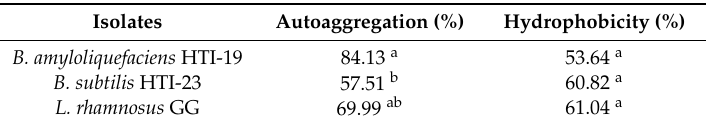
Table 4. Cell adhesion activity of selected probiotic species.